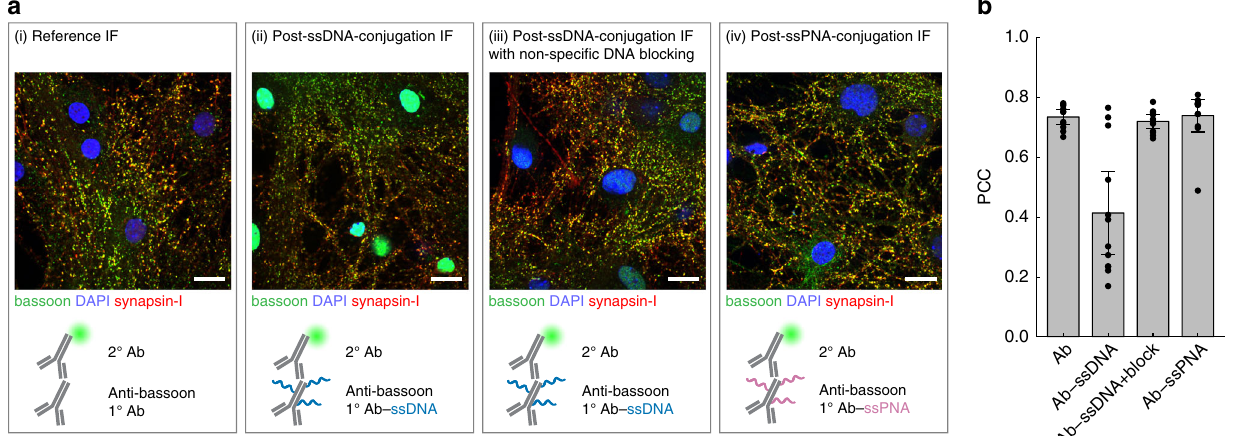
Fig. 2 Blocking off-target nuclear localization of ssDNA-conjugated antibodies. a Neurons were stained with native or ssDNA-conjugated anti-bassoon antibody, anti-synapsin-I antibody, and DAPI. ssDNA-conjugated anti-bassoon antibody exhibited strong off-target nuclear localization (ii, green staining inside the nuclei), compared to the native antibody (i). This nuclear localization was reduced by blocking the fi xed sample with non-speci fi c (salmon sperm) DNA prior to immunostaining (iii) or when the anti-bassoon antibody used for staining was conjugated with ssPNA instead of ssDNA (iv). Scale bars: 20 μ m. b Cross-correlation analysis of the IF images in a . Pearson correlation coef fi cient (PCC) of the bassoon channel (green in a ) with the synapsin- I channel (red in a ) for each image. Differences in PCC indicate changes in antibody staining patterns. Error bars represent 95% con fi dence